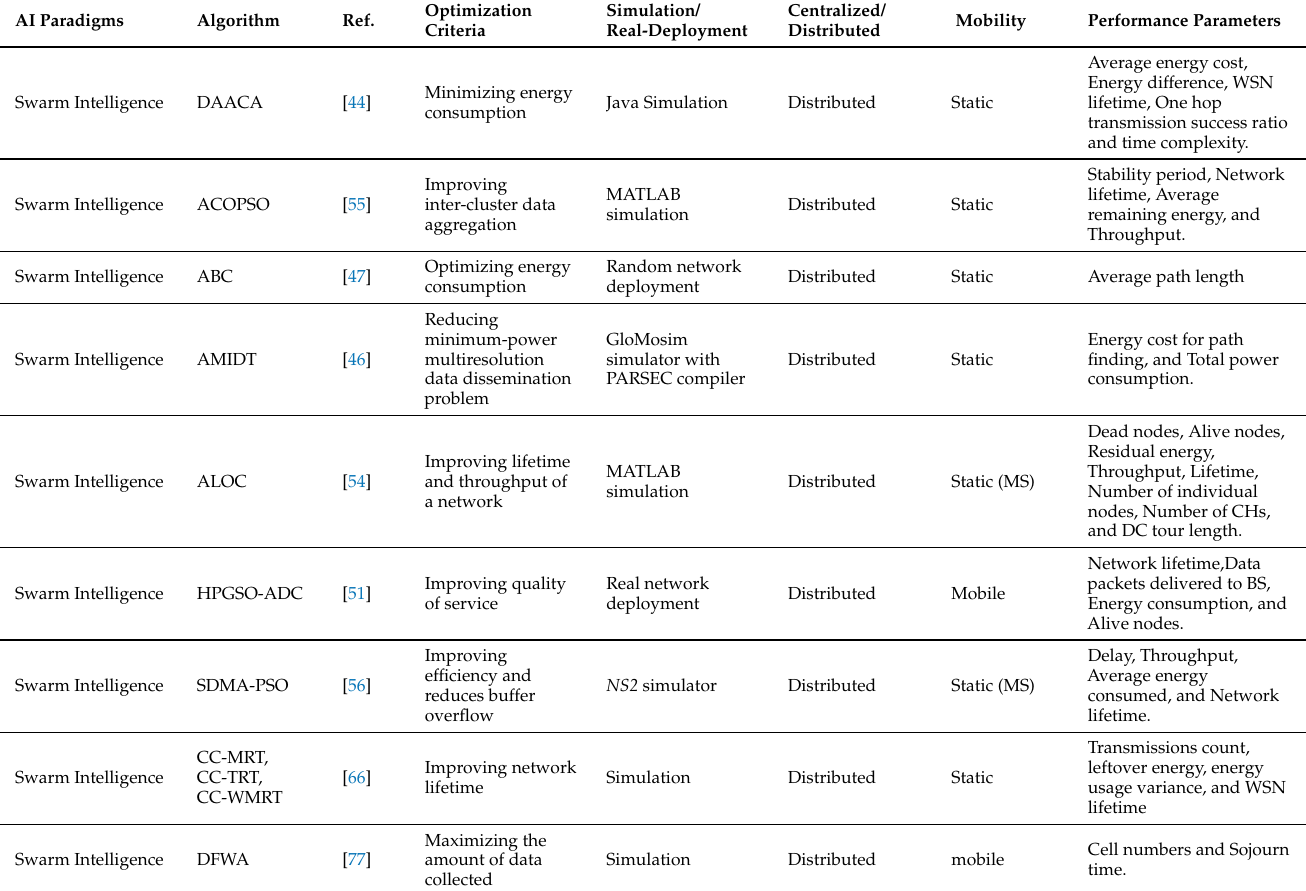
Table 2. Summary of AI based solutions to WSN DC, aggregation and dissemination issues surveyed in Section